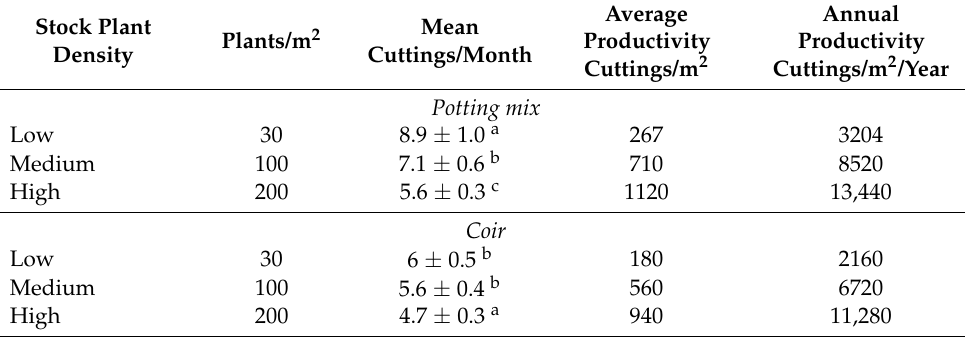
Table 4. Productivity of tea tree ( M. alternifolia ) stock plants. Means followed by the same letter are not significantly different at the 95% confidence